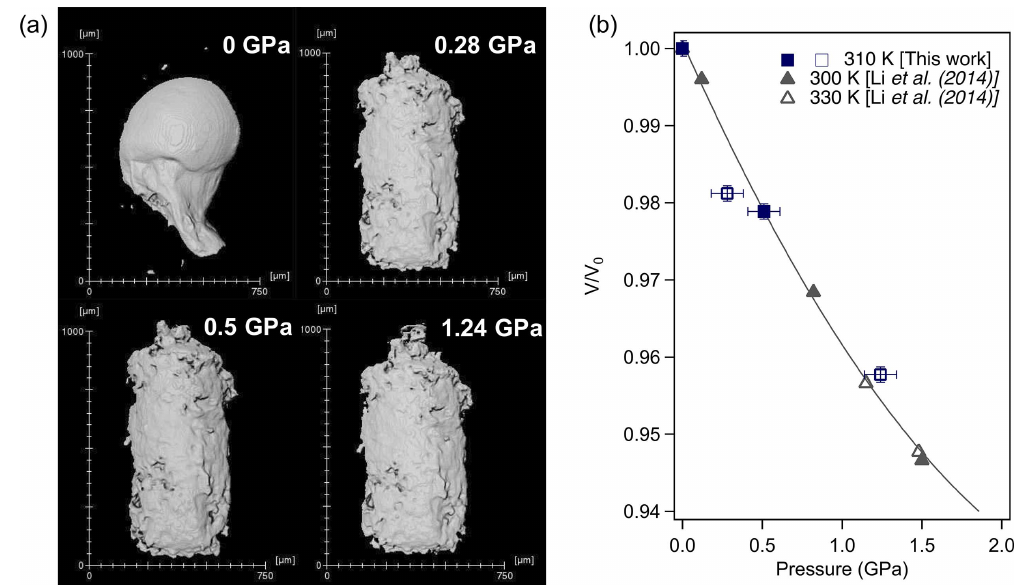
Figure 6 ( a ) Volume of liquid gallium at selected pressures and 310 Kobtained by segmentation using the Otsu criterion in the Avizo software. We notice at room pressure that some small particles are apart from the main part of the sample. ( b ) Corresponding relative volume evolution under pressurizing liquid gallium. Full and empty square markers correspond to measurement before and after the pressure loss, respectively; full and empty triangle markers are taken from the paper by Li et al. (2014) at 300 K and 330 K, respectively; the solid line is a guide to the